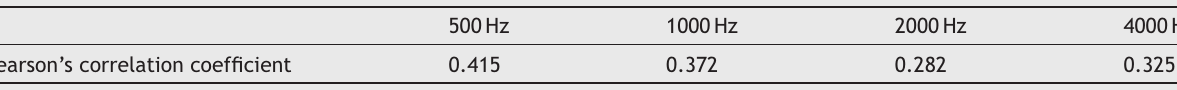
Pearson’s correlation coefficient found for each frequency analyzed.